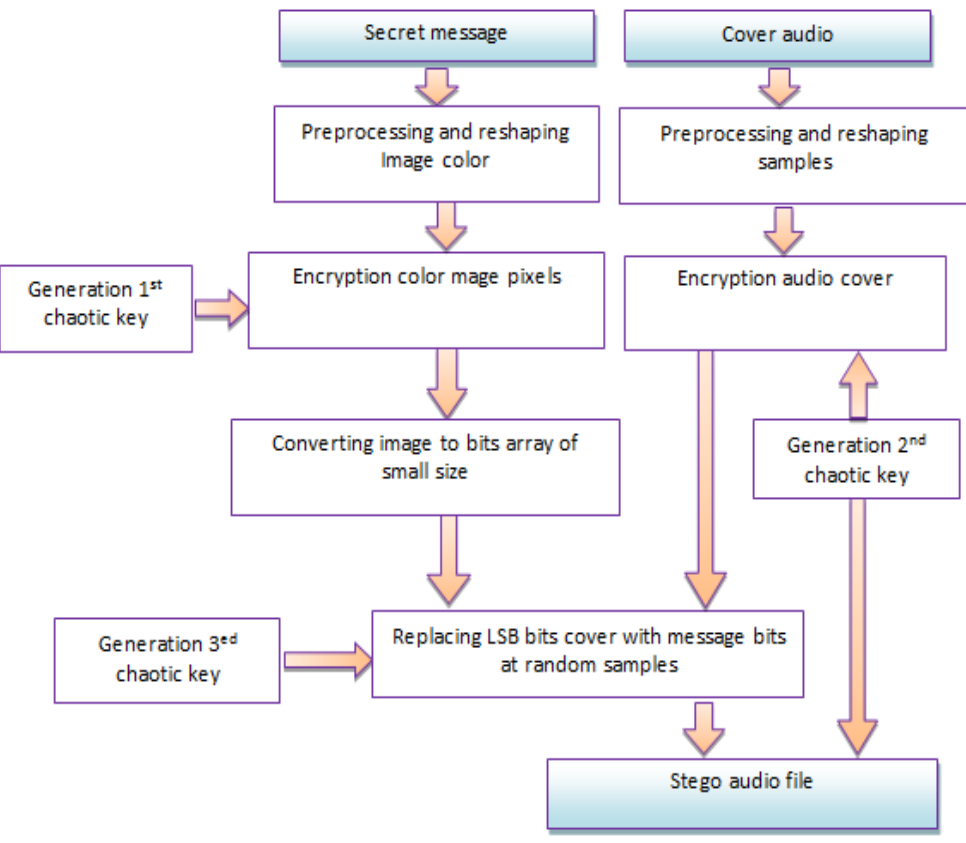
Fig.2: General block diagram of the proposed